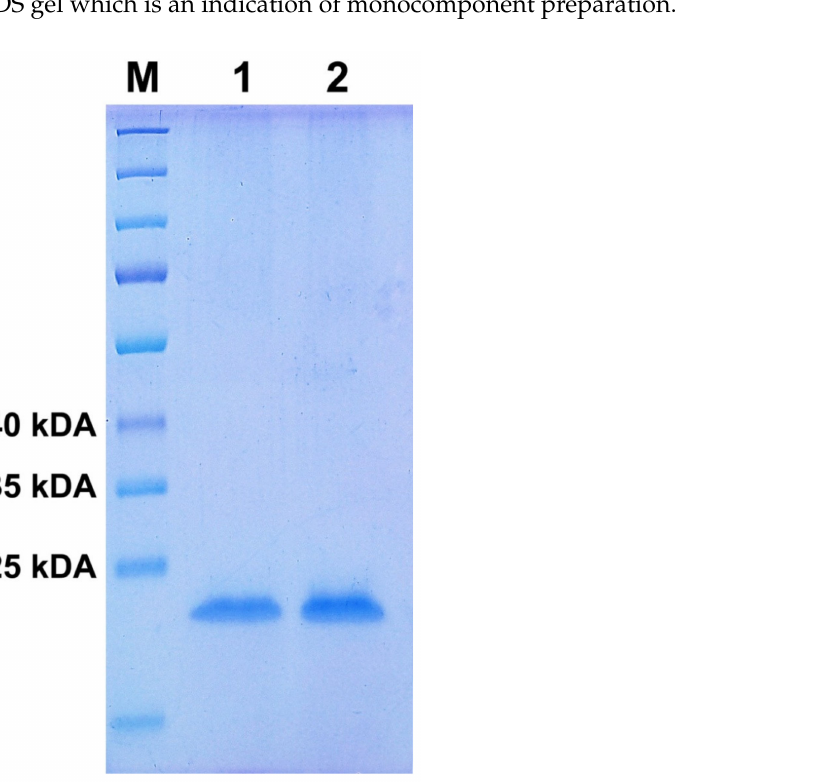
Figure 1. SDS page electrophoresis of IFN β -1a 2.6 µ g of Rebif (1–2) and ReciGen (3–4); M is a ladder from 25 kDa to 200